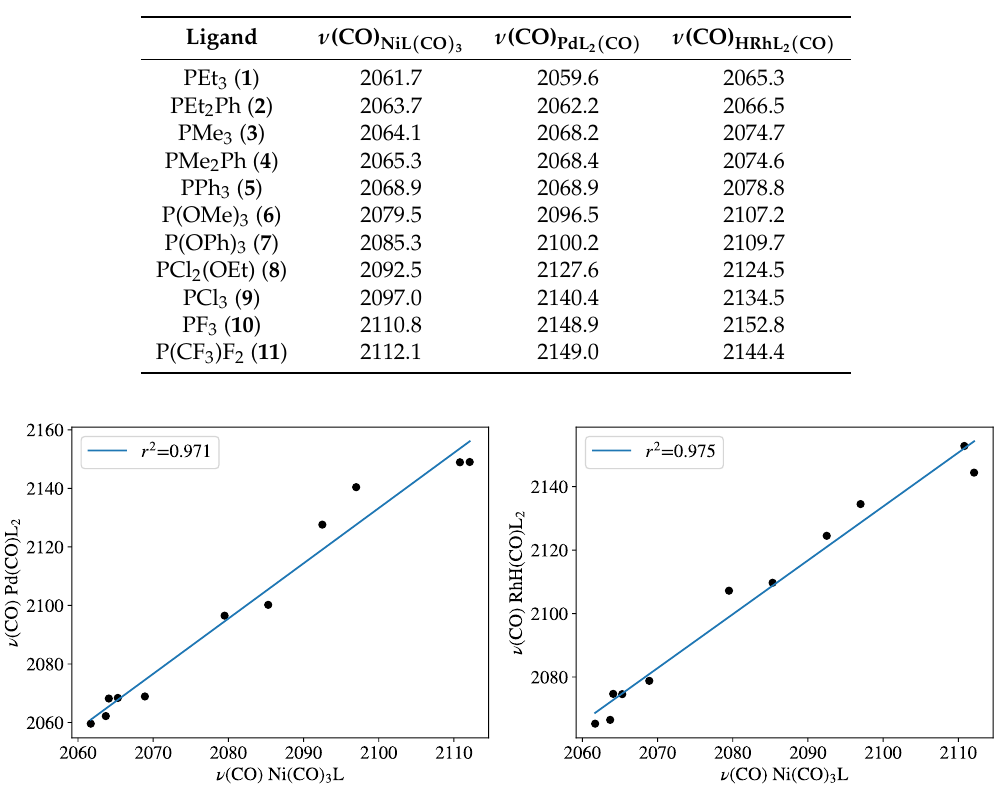
Table 1. Experimental CO-stretching frequencies (Reference [12]) for NiL(CO) 3 , and computed CO- stretching frequencies for PdL 2 (CO) and HRhL 2 (CO) complexes at the B97D3 level of theory. Carbonyl- stretching frequencies are given in cm − 1 .